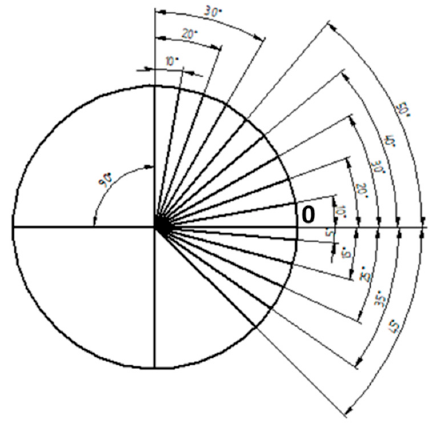
Figure 10. The star model ( 𝑛 (cid:3404) 13 lines).